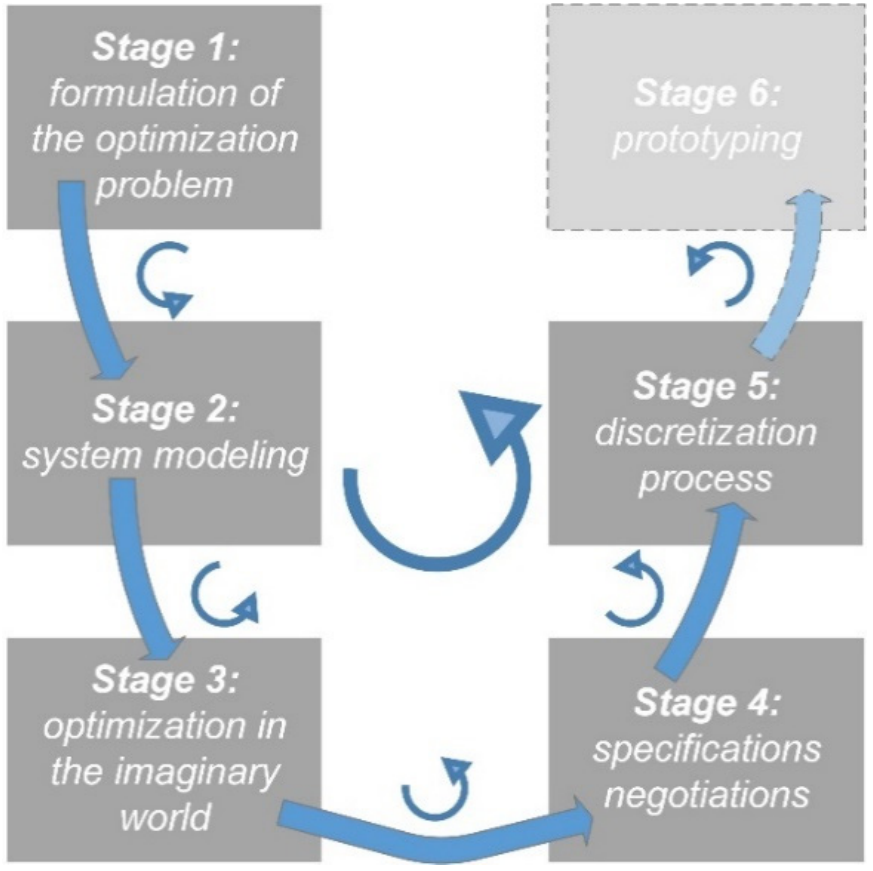
Figure 3. Description of the proposed